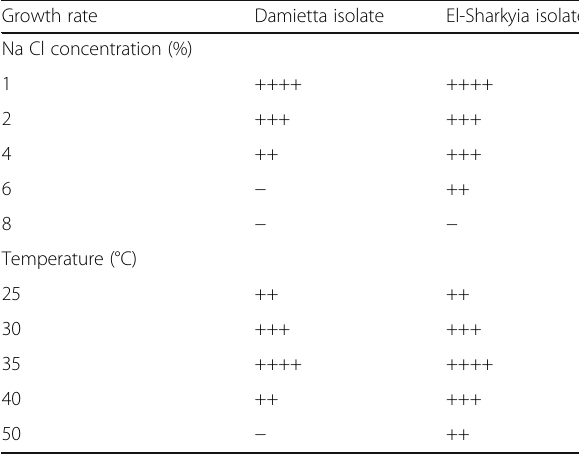
Table 4 Growth of Bacillus thuringensis isolates in different